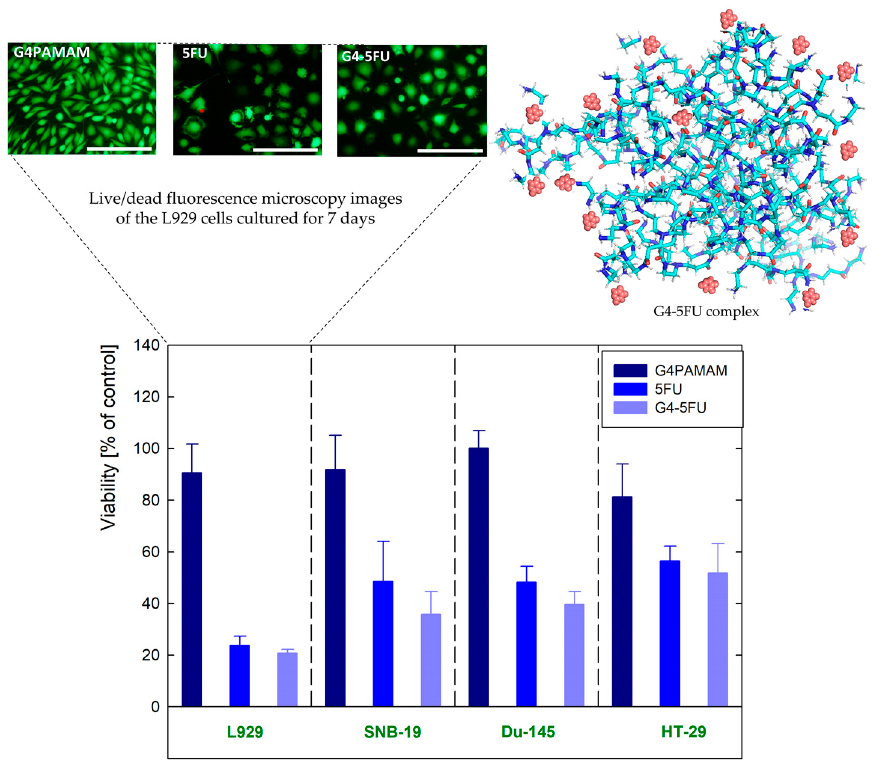
Figure 1. The initial evaluation of cytotoxicity of dendrimers and their complexes with 5FU against mouse fibroblasts (L929), glioblastoma (SNB-19), prostate cancer (Du-145), and colon adenocarcinoma (HT-29) determined via metabolic activity assay of the cells cultured for 7 days in the presence of G4PAMAM dendrimers, G4-5FU complexes, and 5FU, with concentration corresponding to its concentration in complex [15].